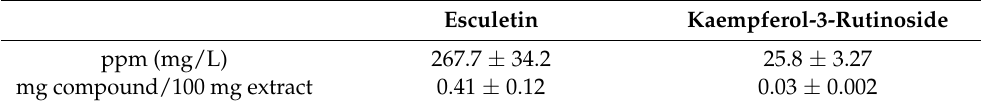
Table 3. Quantification of bioactive compounds of the ethanolic extract from the defatted flour of Euphorbia lathyris .